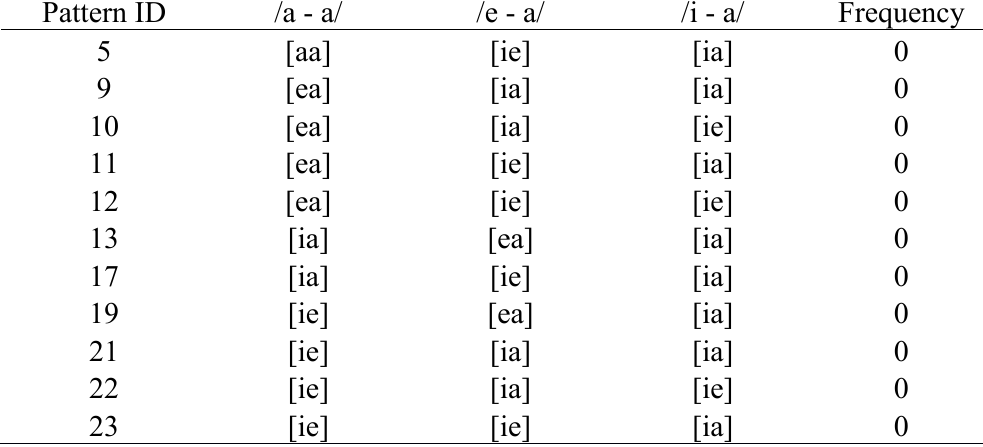
Table 7 . Logical patterns which are unattested in the dataset